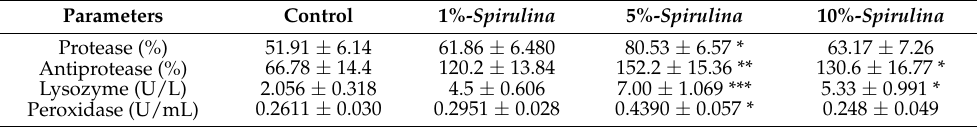
Table 4. Skin mucus enzyme activity of grass carp fed with 0, 1, 5, 10% Spirulina for 90 days.